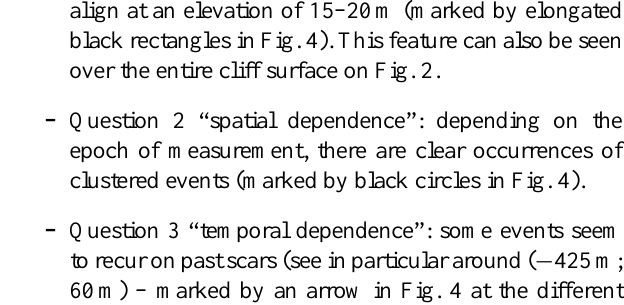
Figure 3. (a) Relationship between the ratio of erosion scars’ width to the overall cliff length (%) and the volume (m 3 ).The red horizon- tal line outlines the threshold at 1%; (b) relationship between the ratio of erosion scars’ height to the overall cliff height (%) and the volume (m 3 ). The red horizontal line outlines the threshold at